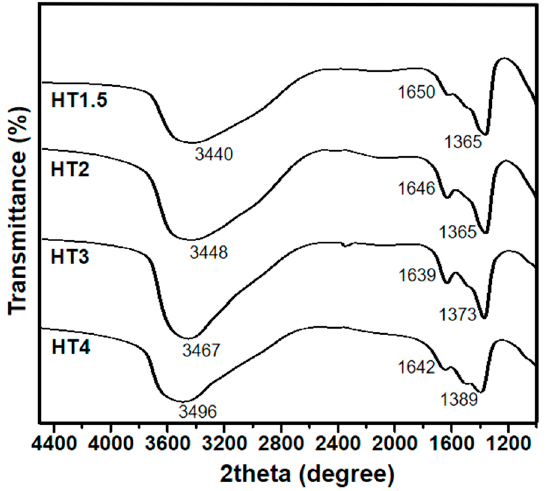
Figure 3. Fourier transform infrared (FTIR) spectra of the prepared HTX catalysts (X = 1.5, 2, 3, and 4).